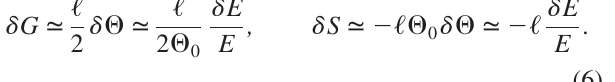
FIG. 3. (Color) A scheme of a four-crystal (A, B, C, and D) x-ray optical cavity allowing a broad range of energy tuning assuming that the focusing elements are the compound refractive lenses (CRLs) [12]. See text for other